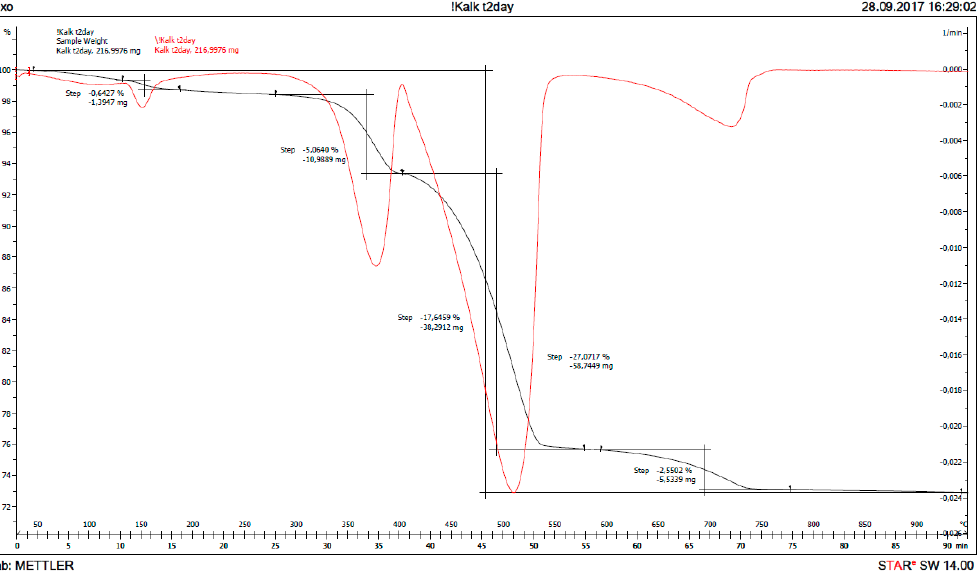
Figure 13. The thermogravimetry curves (TG) in black and its derivative (DTG) in red for the solids of 1% CaO dispersed in sea water for 2 days.